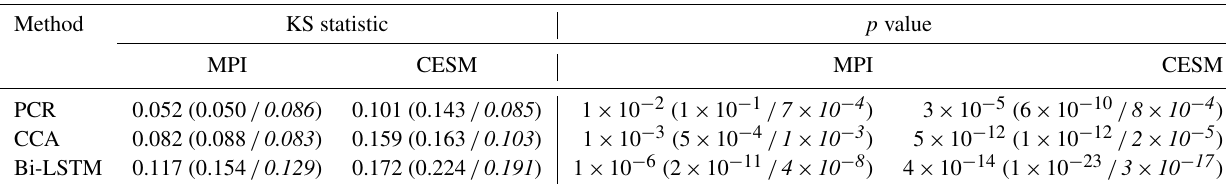
Figure 15. The same as Fig. 14 but for the decadal filtered AMV index. Table 5. The same as Table 4 but for the AMV